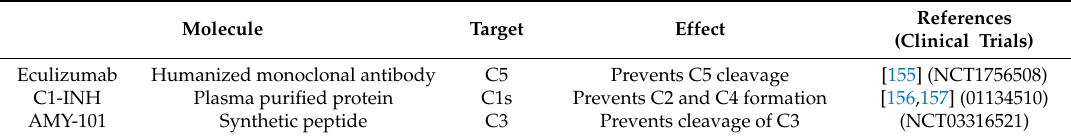
Table 1. Liver transplant therapeutics targeting